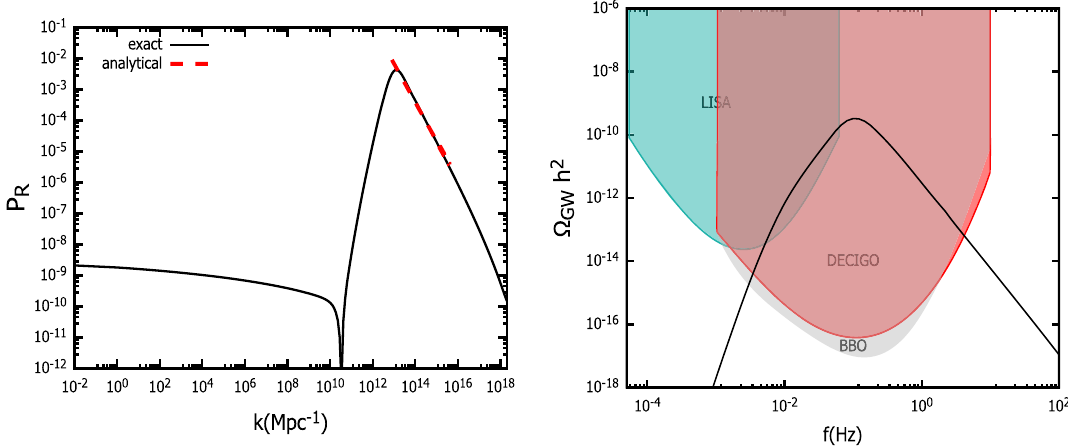
Fig. 5 The power spectrum (left) with solid line (numerical) and with dashed (analytical from Eq. 2.34). The density of stochastic GWs (right) for the case of modifying Wess–Zumino. We choose for the parameters b 3 = 87 . 38, c = 0 . 065, c 3 = − 4 and λ/μ = 0 .